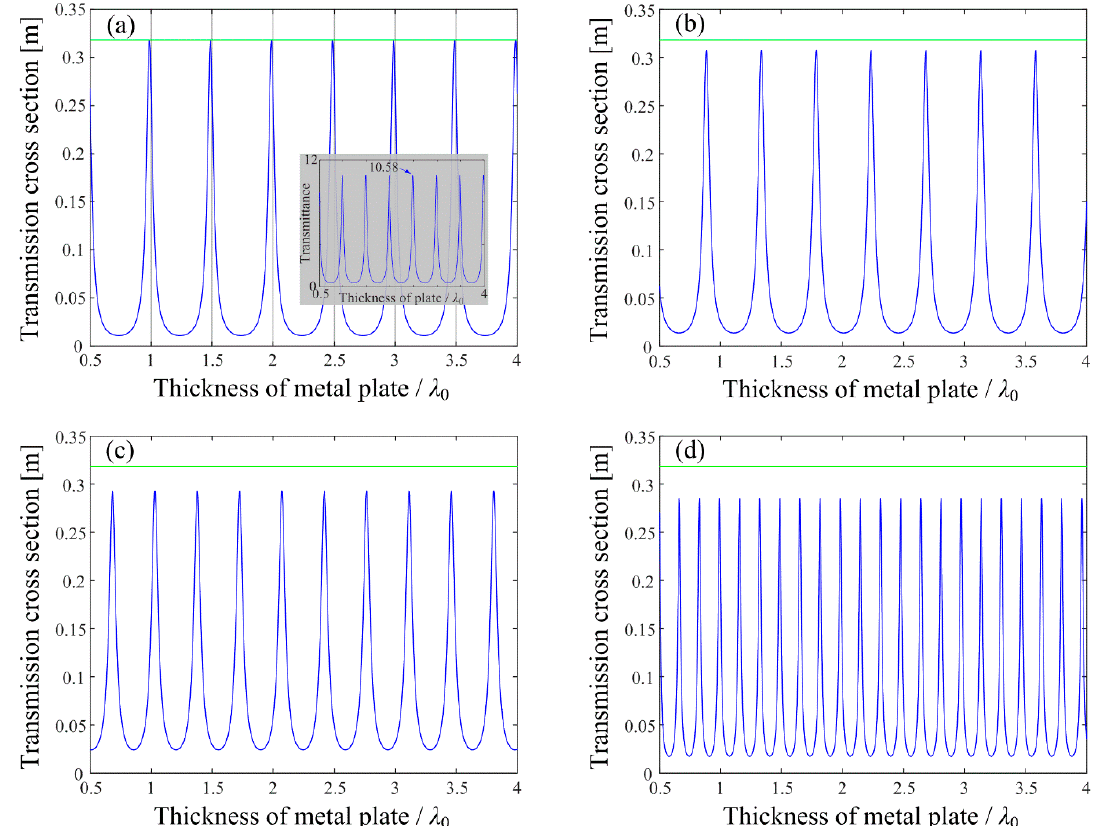
Figure 2. Transmission cross-sections (TCSs) for various permittivities: ( a ) metal which is a perfect electric conductor (PEC); ( b ) ε r = − 2000; ( c ) ε r = − 100; and ( d ) ε r = − 5. The transmittance for the PEC case is shown in the inset of ( a ).